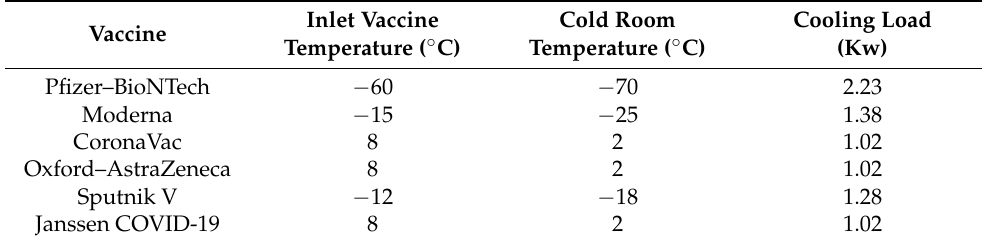
Table 2. Vaccine thermal